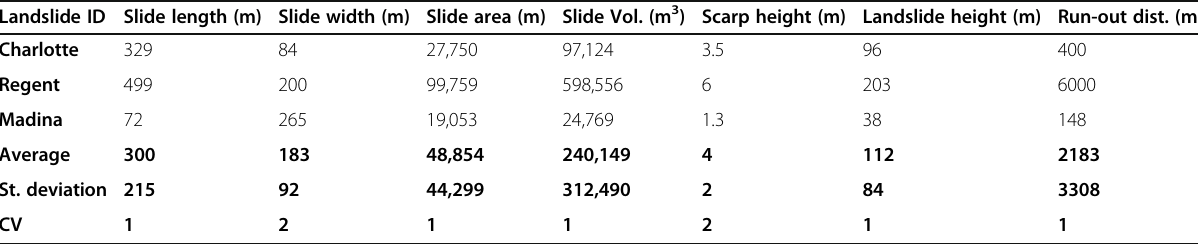
Table 4 Geometric Parameters of the Charlotte, Regent and Madina